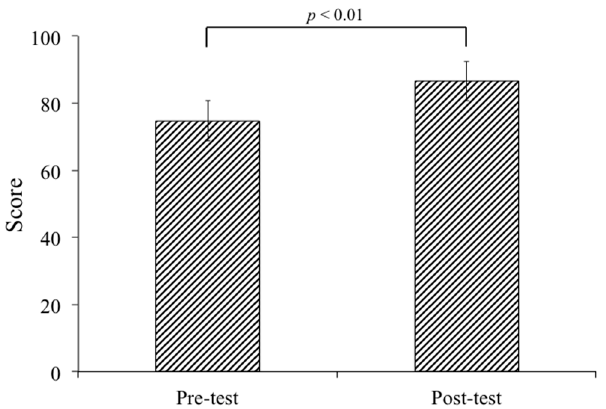
Figure 5. The average scores of National OSCE were higher in the experimental group than the scores in the control group (214.8 in the experimental group vs. 206.5 in the control group, p < 0.001).